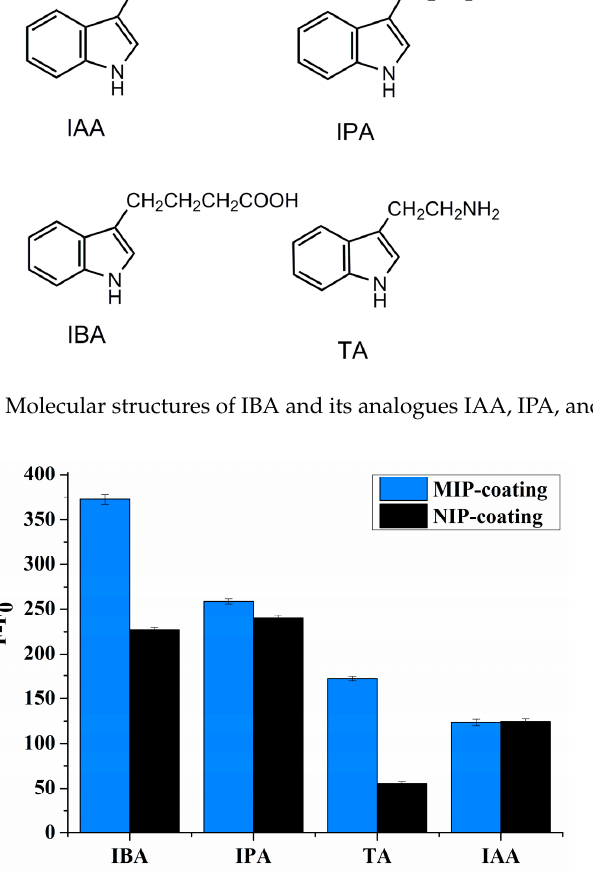
Figure 6. Fluorescence intensities of IAA, IPA, and TA adsorbed on the MIP/NIP coating (10 mg · L − 1 target solutions in buffer pH = 2.5, λ ex/em = 294/370 nm).